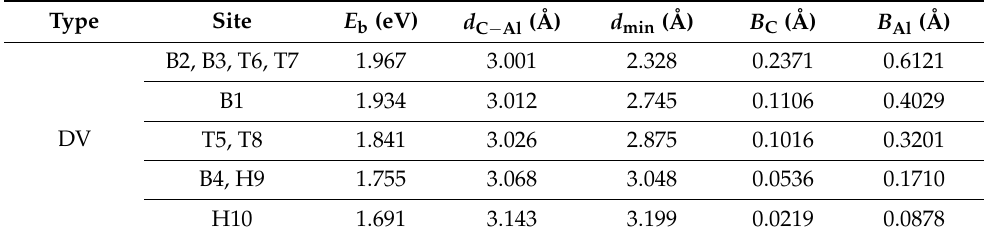
Table 4. The key parameters of the DV graphene/Al (111) interface after